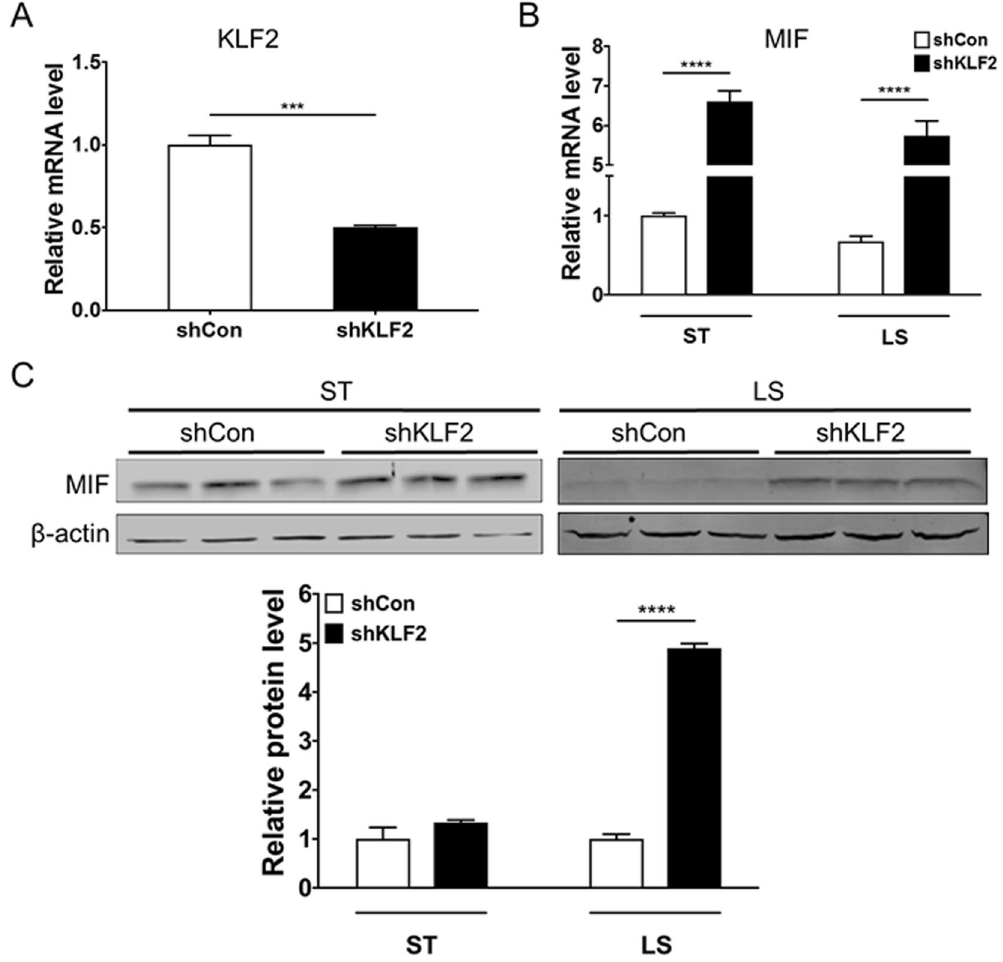
Figure 4. Knockdown of KLF2 prevents LS-induced reduction of MIF. HUVECs were infected with adenovirus-shKLF2 or -shControl for 48 hours before LS stimulation for 24 hours. The RNA expression of KLF2 ( A ) and MIF ( B ) were detected by qPCR. ( C ) Representative Western blot of intracellular MIF and β -actin in ECs infected with adenovirus-shKLF2 or -shControl under static culture (ST) or LS conditions. Data shown are presented as mean ± SEM. *** P < 0.001, **** P <